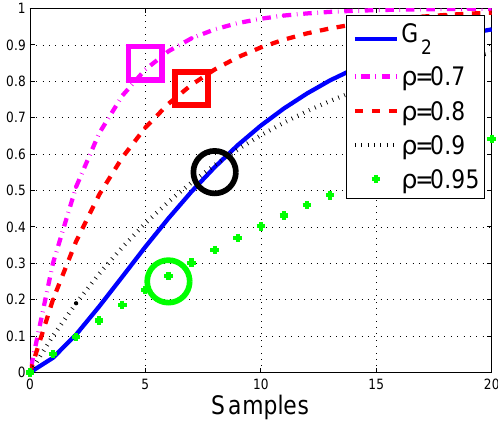
Figure 9. Open-loop step response overlaid with several possible targets and potential coincidence